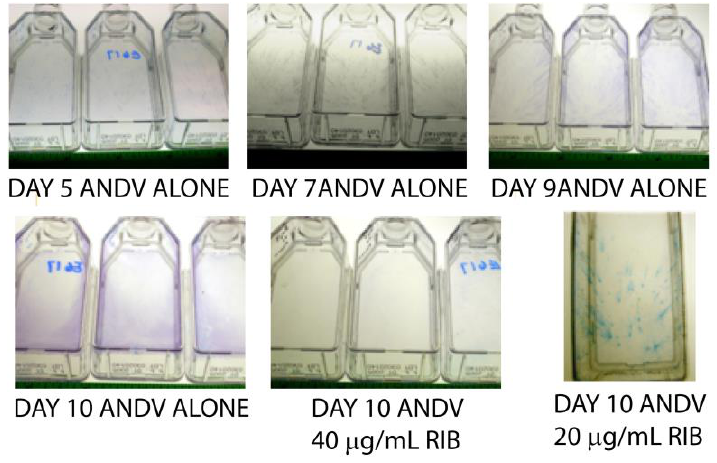
Figure 1. Visual representation of antiviral activity of ribavirin in a comet spread assay with Andes virus (ANDV). Representative culture flasks stained for the presence of the ANDV glycoprotein are shown different days post-infection with ANDV in the presence or absence of ribavirin. ANDV staining on Day 10 at 20 and 40  g/mL ribavirin shows an inhibition of staining or spread at 40  g/mL ribavirin but not 20  g/mL ribavirin. With ANDV alone, an increase in the level of stain is observed over Days